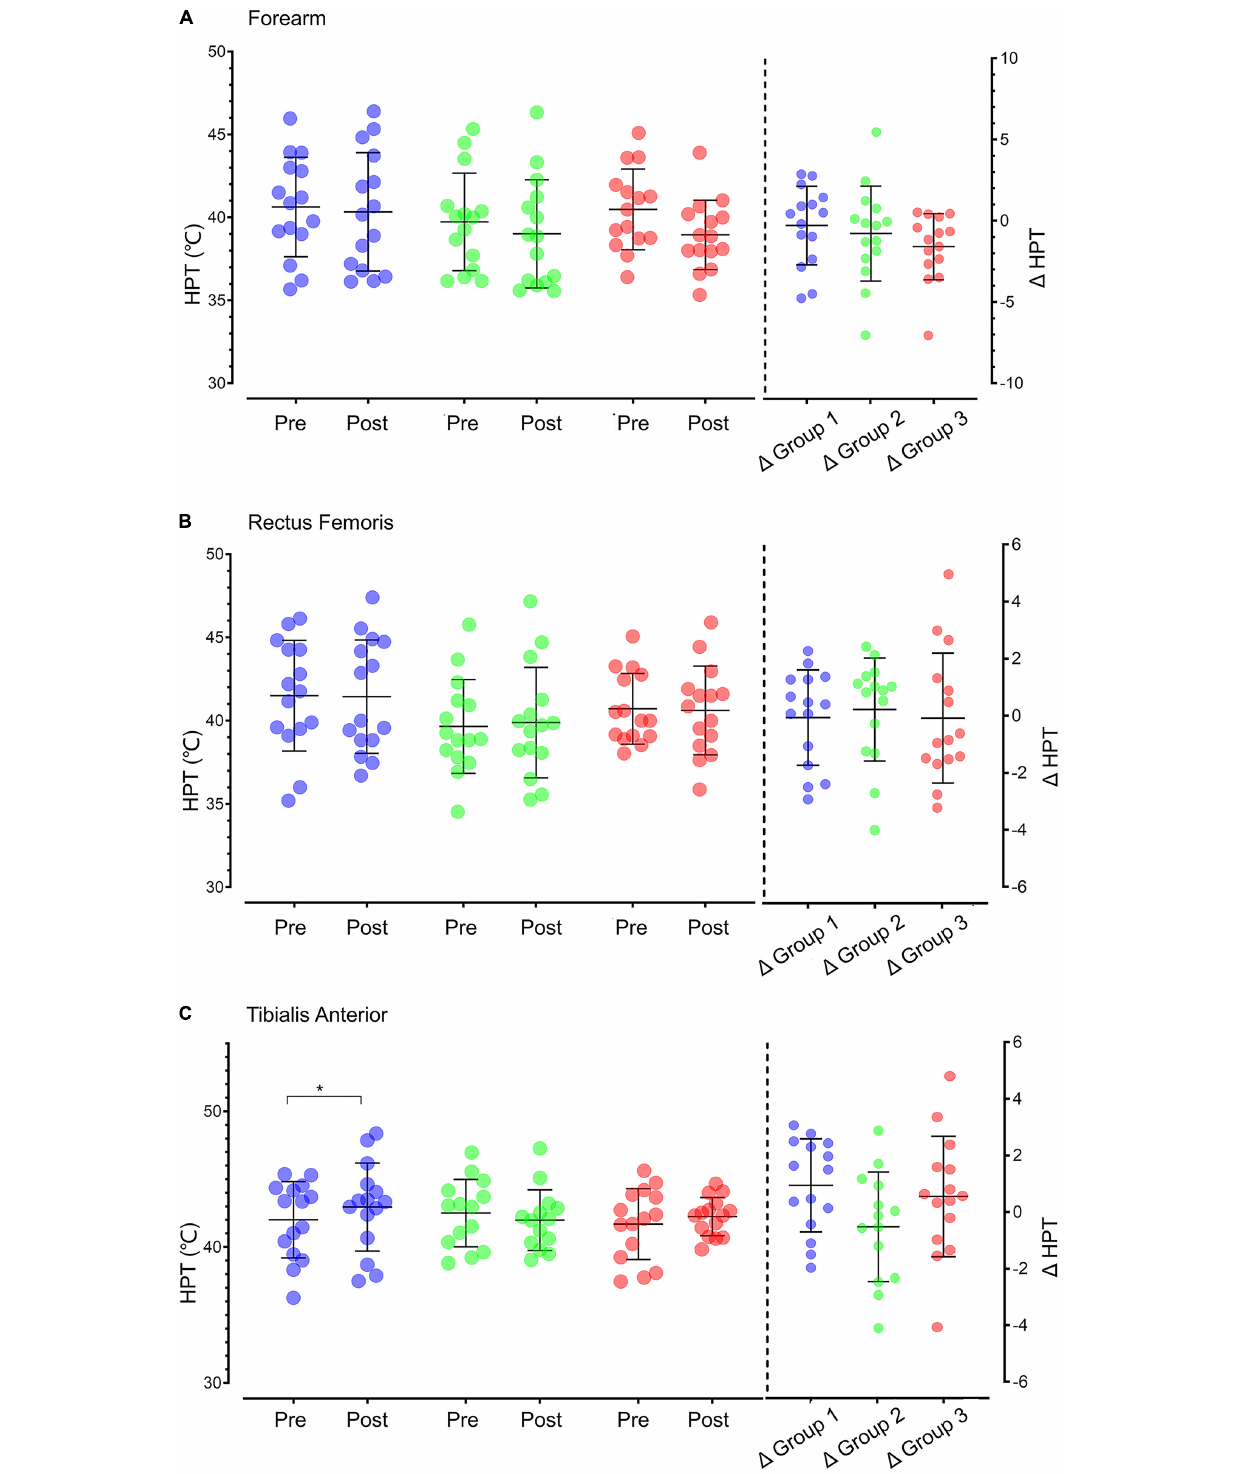
Frontiers in Neuroscience |